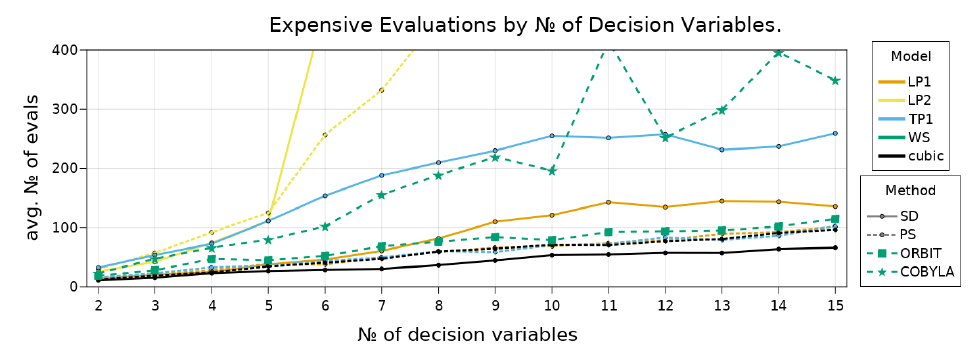
Figure 3. Average number of expensive objective evaluations by number of decision variables n , surrogate type and descent method. “SD” refers to steepest descent and “PS” to Pascoletti–Serafini. “LP1” (orange) are linear Lagrange models, “LP2” (yellow) quadratic Lagrange models, “TP1” (blue) are linear Taylor polynomials based on finite differences and “cubic” (black) refers to cubic RBF models. Additionally the results for weighted sum runs are shown in green, using the COBYLA solver and a single objective variant of the trust region framework, ORBIT